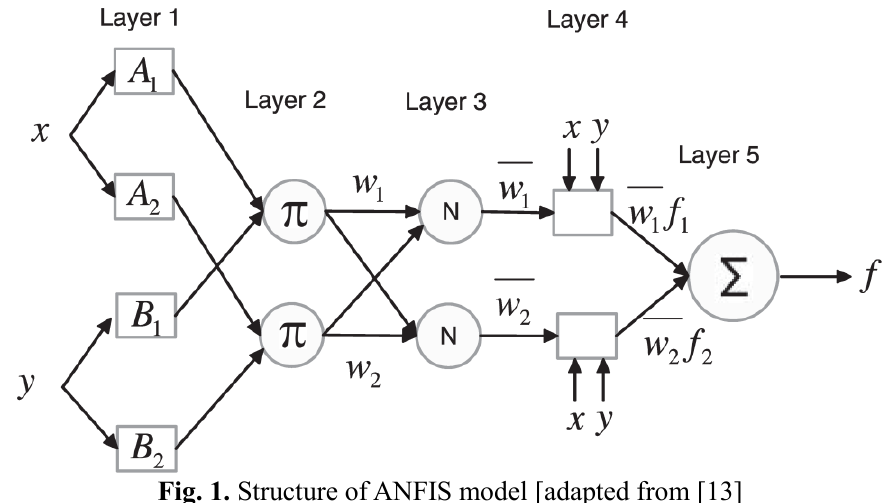
Fig. 1. Structure of ANFIS model [adapted from